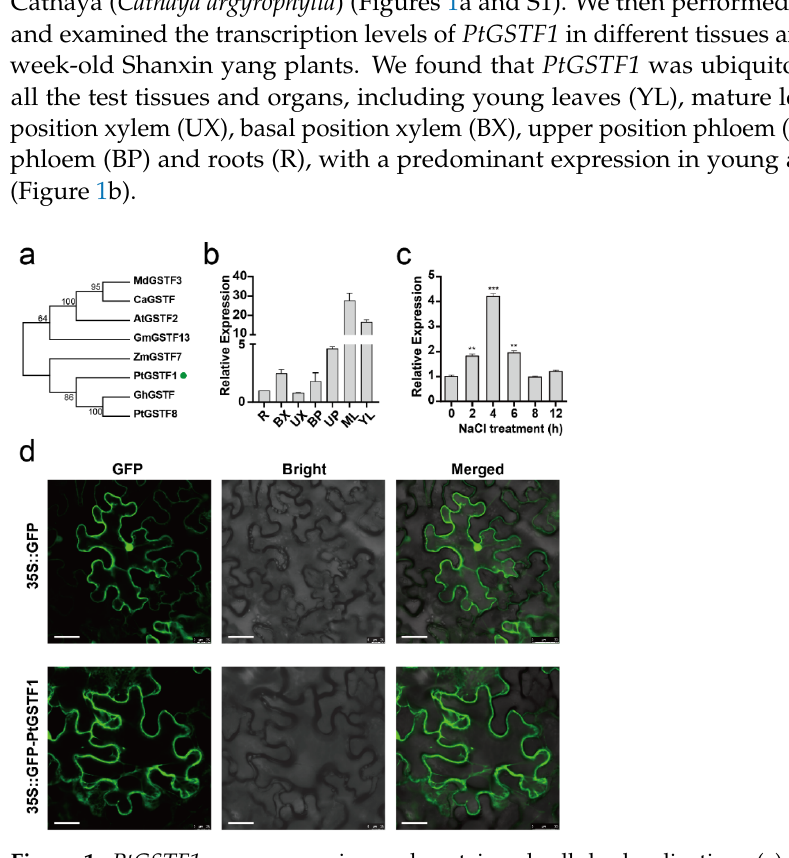
Figure 1. PtGSTF1 gene expression and protein subcellular localization. ( a ) Phylogenetic tree of PtGSTF1 (Green dot callout) and GSTF members in different plants. The evolutionary history was inferred using the Minimum Evolution method. The percentages of replicate trees in which the associated taxa clustered together in the bootstrap test (1000 replicates) are displayed next to the branches. ( b ) Quantitative RT-PCR (qRT-PCR) analyses. PtGSTF1 expression in different tissues and organs of eight-week-old wild type Shanxin yang plants was determined. PtEF1 β was used as an internal control. R, roots; BX, xylem tissues at the basal position of stems; UX, xylem tissues at the upper position of stems; BP, phloem tissues at the basal position of stems; UP, phloem tissues at the upper position of stems; ML, mature leaves; YL, young leaves. Error bars represent the standard deviation (SD) of three biological replicates. ( c ) PtGSTF1 expression in response to salt stress. Four-week-old wild type Shanxin yang plants were treated with 150 mM NaCl for 2, 4, 6, 8 and 12 h. ( d ) Subcellular localization of 35S::GFP and 35S::GFP- PtGSTF1 fusion proteins in tobacco ( Nicotiana benthamiana ) leaf epidermal cells, scale bar = 50 µ m. **, p < 0.01; ***, p <